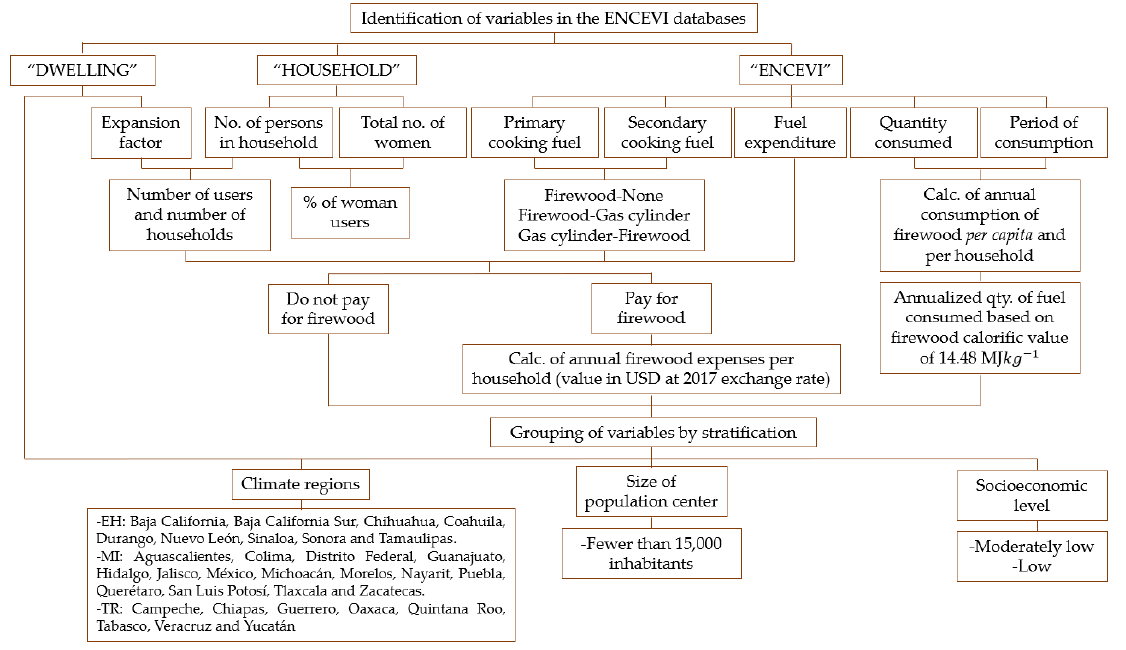
Figure 1. Methodology for the selection and grouping of data for the ENCEVI survey for the purposes of calculating annual per capita consumption of firewood, per household, and for determining number of users and households. Source: Own elaboration.